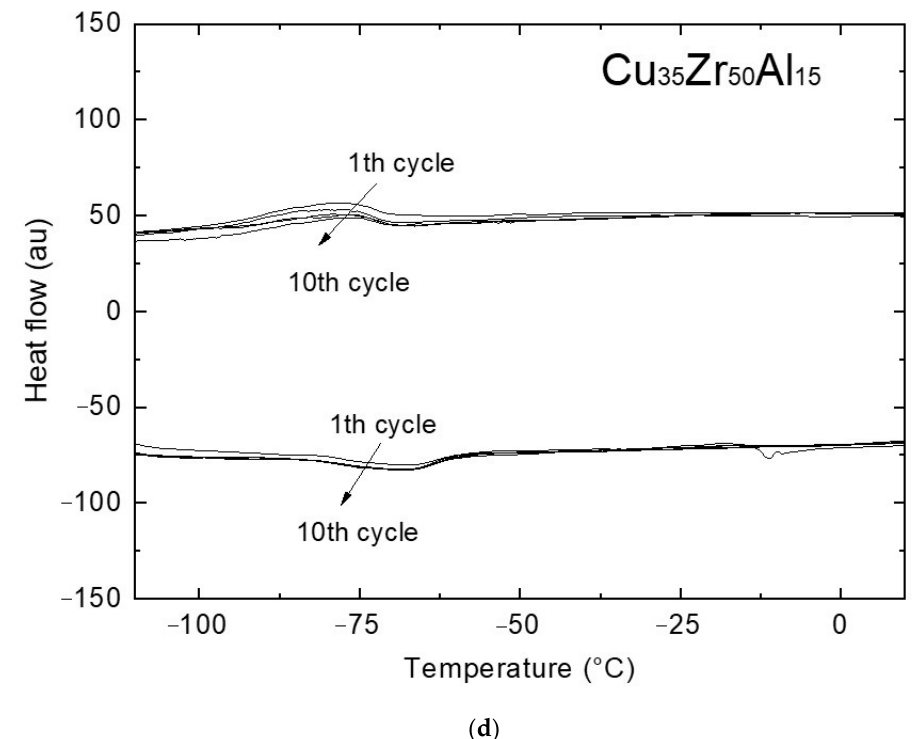
Figure 3. DSC scans of CuZr based alloys: MT after stabilization of Cu 50 Zr 50 alloy ( a ); thermal cycling of Cu (50 − x) Zr 50 Al x alloys with Al = 5, 10, 15 at. % ( b–d ), respectively.